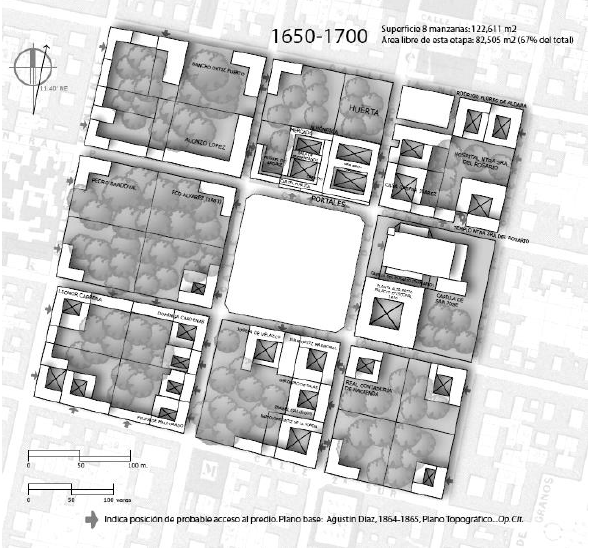
Figure 4. The “apple cores” in the middle of each block. Other evidence is: wall thickness (the thicker, the older), different housing roof systems, volumetric arrangement (the plainer, the older), finishes, features and window openings, among others.